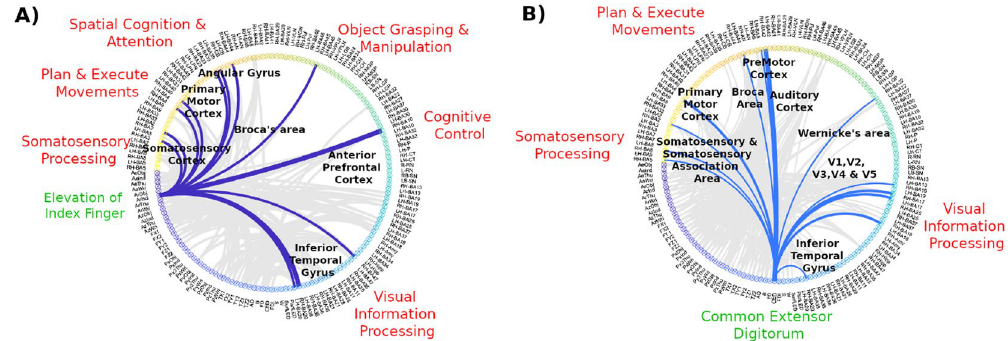
Figure 6. Interpretability of the subject-specific BI-SNN models. ( A ) The connectivity patterns of the BI-SNN trained using data from participant 1. The connectivity between the SPAN index-elevation population vector and the spiking neurons in the 3D NeuCube SNN reservoir corresponds to different brain regions are highlighted as an exemplification. ( B ) The connectivity patterns of the BI-SNN trained using data from participant 3. The connectivity between the SPAN CED population vector and the spiking neurons in the 3D SNN reservoir corresponds to different brain regions are highlighted as an